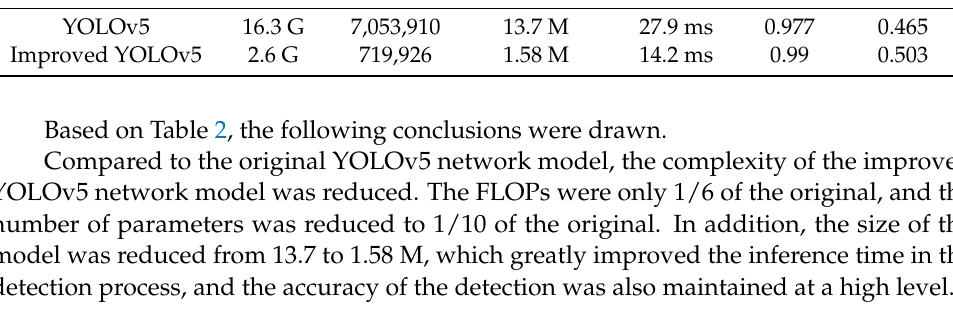
Table 2. Comparison of YOLOv5 and improved YOLOv5 network structures.